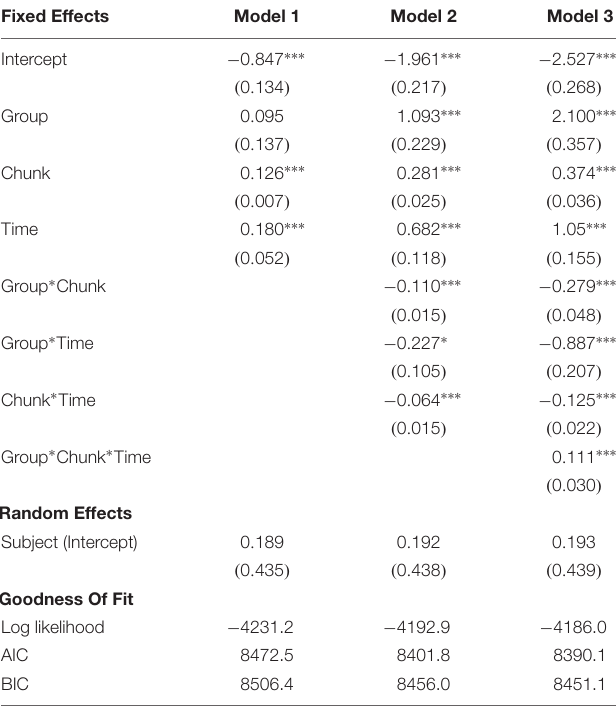
TABLE 7 | Summaries of the two generalized linear mixed effects